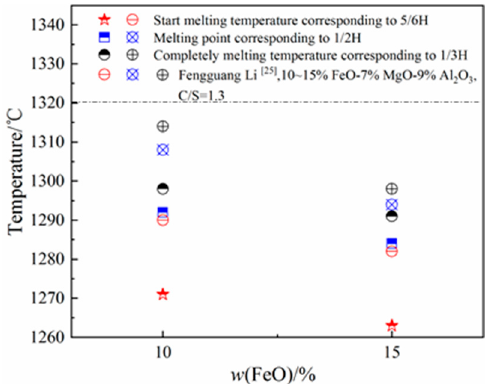
Figure 3. Starting melting temperature, hemisphere point temperature, and complete melting temperature of the sample at different w (FeO).